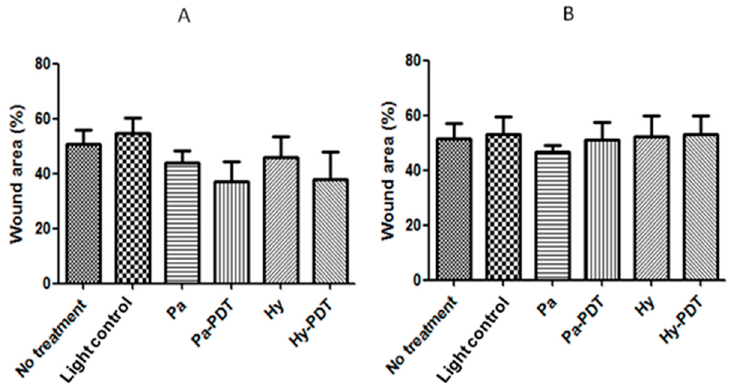
Figure 5. Wound areas in different groups of mice after intravenous injection treatment with or without PDT. ( A ) Pa and Hy 2.5 mg/kg irradiation for 30 s for PDT groups; ( B ) Pa and Hy 2.5 mg/kg, irradiation for 10 min for PDT groups. Data are mean ± SEM ( n = 5).